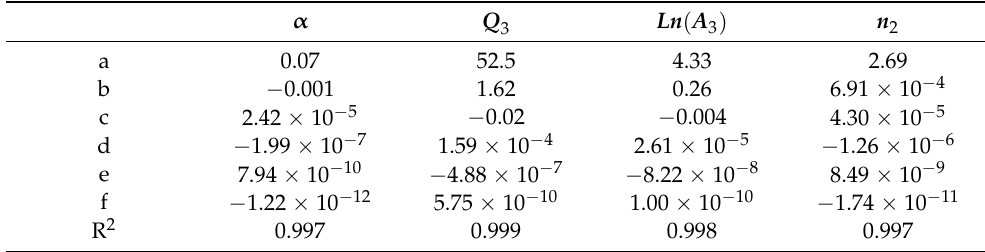
Table 3. The calculated polynomial regression coefficients and R 2 in Equations (18)–(21).